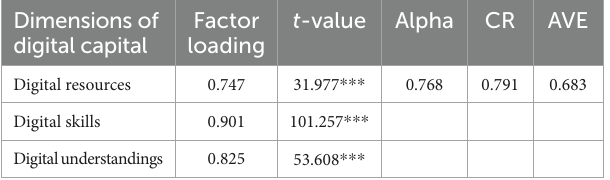
TABLE 6 Factor loadings, convergent validity, and